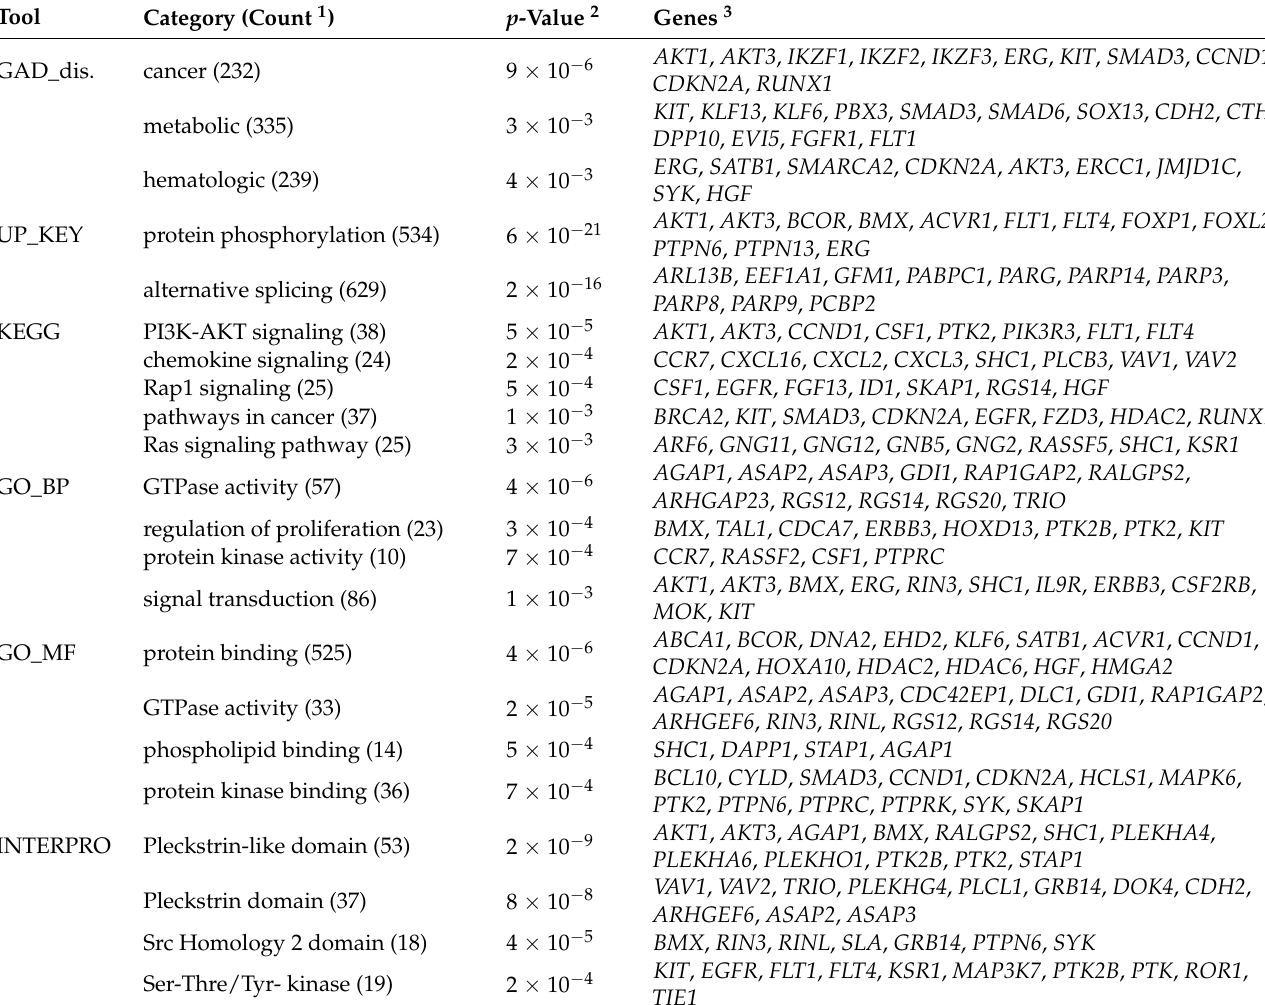
Table 1. DAVID annotation of combined variants and expression sets of AZA resistance involving categories including disease association (GAD), bio-pathways (KEGG), GO terms (biological process, BP) and (molecular function, MF), keywords (upregulated, UP), protein domains